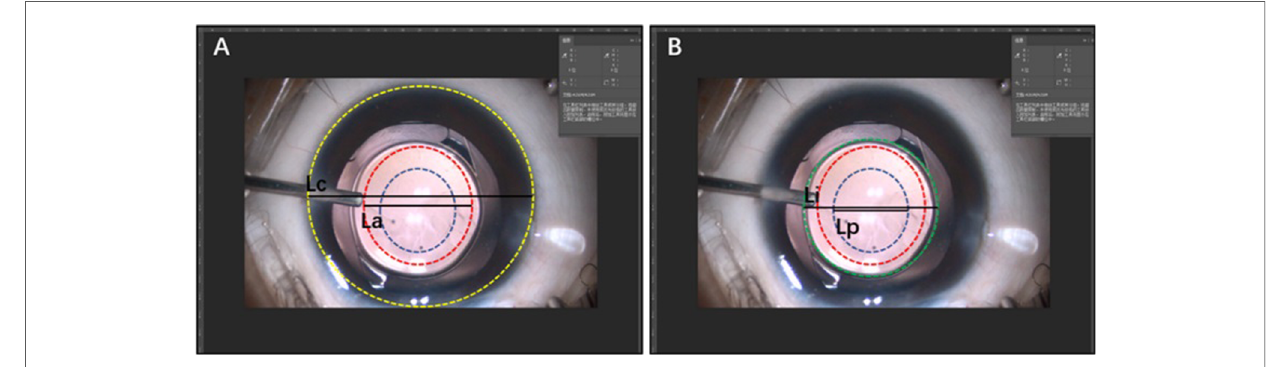
FIGURE 2 Veri fi cation of the accuracy of the measurement method of capsulotomy opening diameter (COD). ( A ) The method converted the values of ACOD and PCOD (mm) through the value of CD (mm). ( B ) The method converted the values of ACOD and PCOD (mm) through the value of the optical surface diameter of the intraocular lens (6